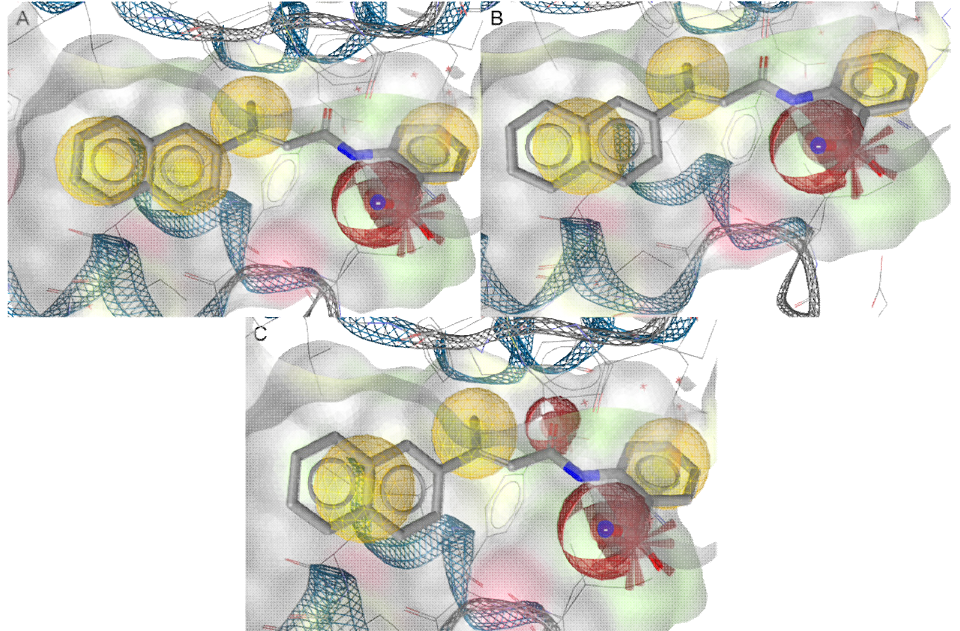
Figure 1. Pharmacophore models derived from the X-ray pose of BIBR1532 (PDB ID: 5CQG): ( A ) static pharmacophore model from the PDB with six features—4 hydrophobic features (yellow spheres), 1 H-bond acceptor (red sphere), and one anionic feature (red star); ( B ) static pharmacophore model after fusing with 5 features—3 hydrophobic features (yellow spheres), 1 H-bond acceptor (red sphere), and 1 anionic feature (red star); ( C ) MYSHAPE pharmacophore model—3 hydrophobic features (yellow spheres), 2 H-bond acceptors (red spheres), and 1 anionic feature (red star).